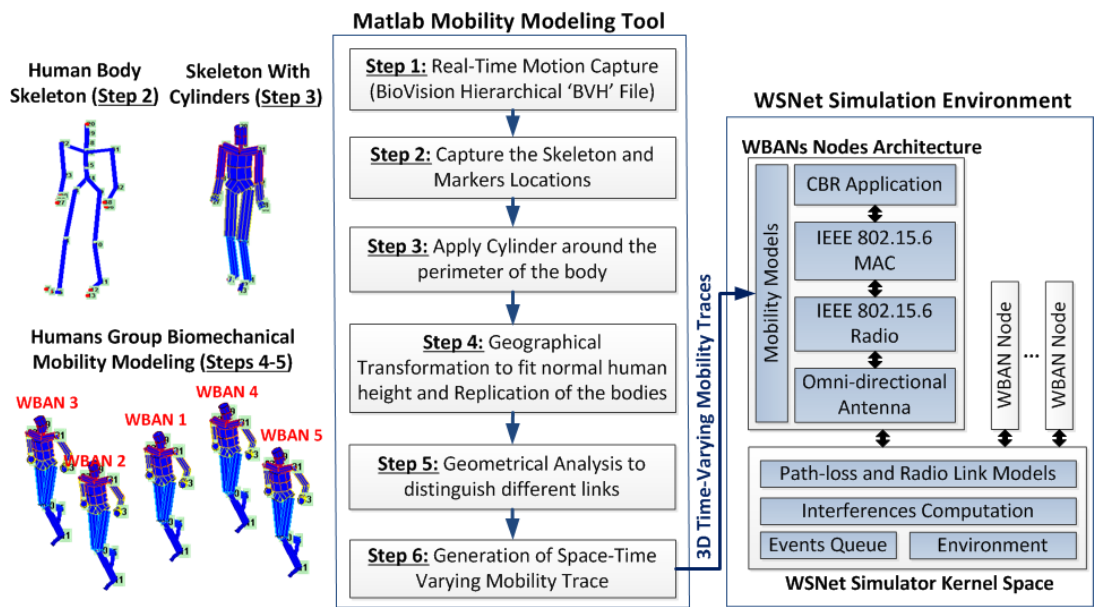
Figure 10. Joint biomechanical, group mobility and radio link modeling for BANs and